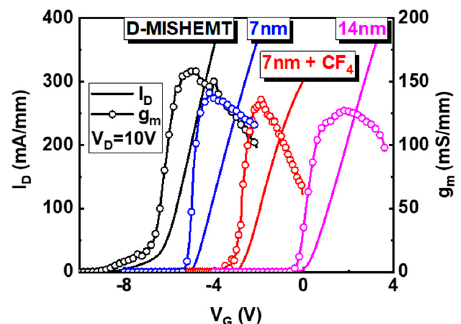
Figure 2. The I-V transfer curves (solid line) and transconductance (open circle line) of AlGaN/GaN MIS-HEMTs with various gate conditions at V D = 10 V. Black, blue, red and pink colors indicate the D-mode device, 7-nm gate recessed, 7-nm gate recessed and CF 4 treatment and 14-nm gate recessed device, respectively.